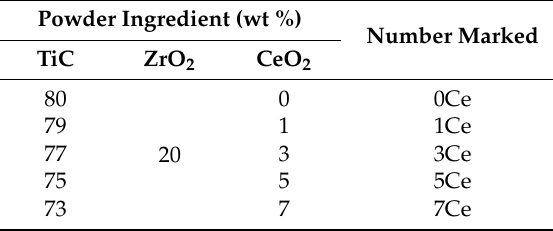
Table 1. The ingredients of the pre-placed powder. Powder Ingredient (wt